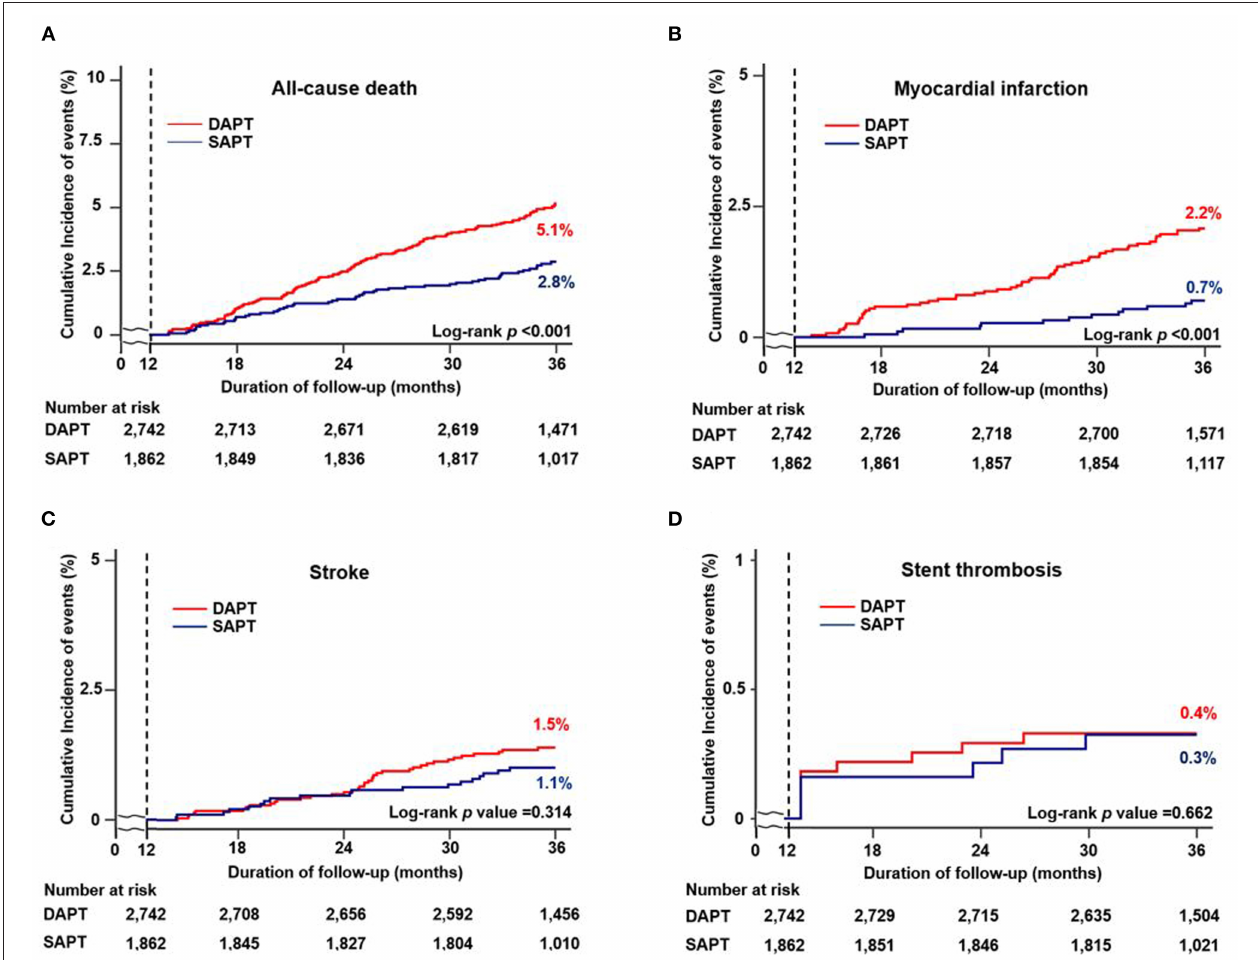
FIGURE 3 | Cumulative incidence of individual clinical outcomes according to antiplatelet agents between 12 and 36 months. Kaplan–Meier curves comparing the rates of (A) all-cause death, (B) myocardial infarction, (C) stroke, and (D) stent thrombosis between SAPT and DAPT. MACCE, major adverse cardiac and cerebrovascular events; SAPT, single antiplatelet therapy; DAPT, dual antiplatelet